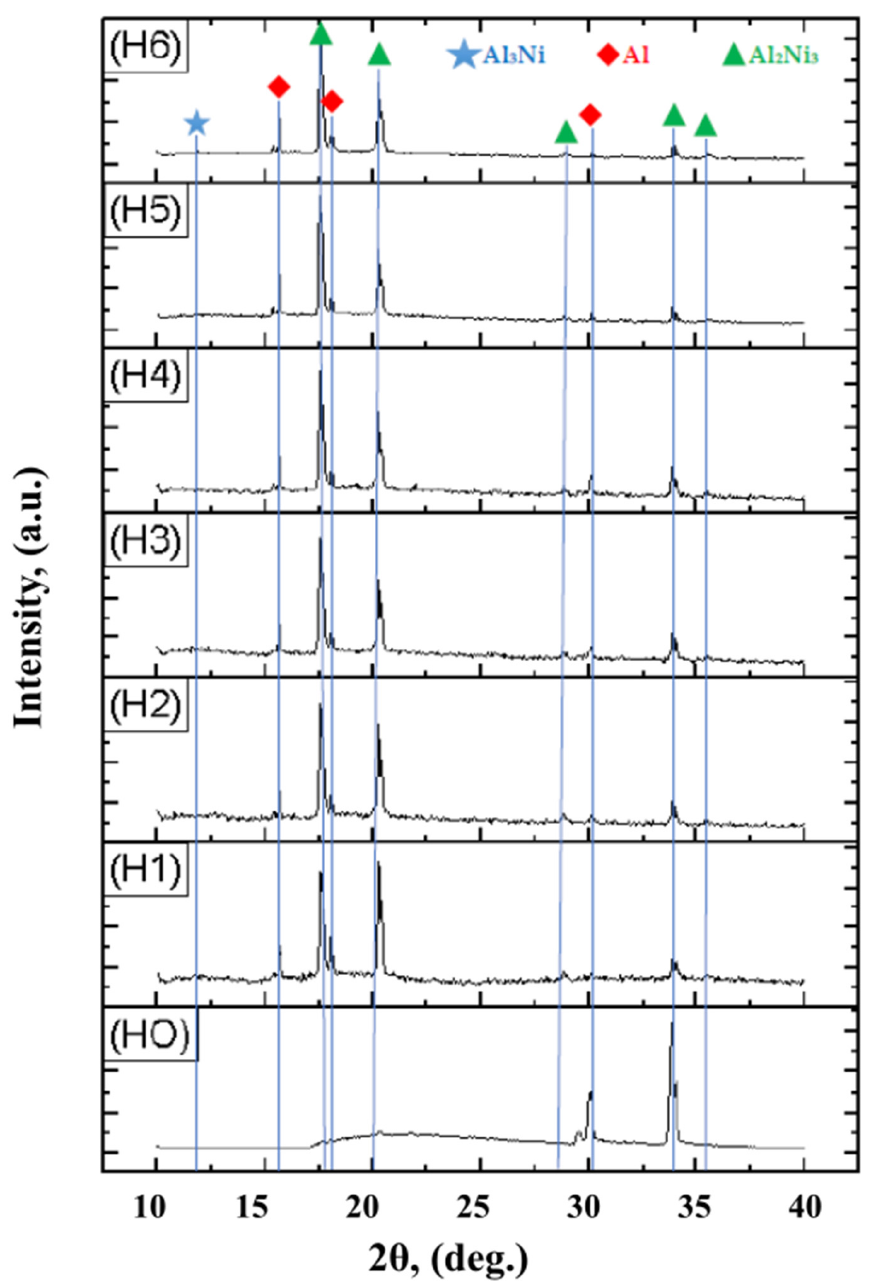
Figure 4. X-ray diffraction patterns taken at different depths (H1 ÷ H6) in relation to the surface of the Al sample (H0 = 0 mm), in the case of an Al-Ni diffusion couple, holding at 650 ◦ C for 50 h; (HO) = 0/surface; (H1) = 0.65 mm; (H2) = 1.15 mm; (H3) = 1.27 mm; (H4) = 1.37 mm; (H5) = 1.55 mm; (H6) = 1.75 mm.